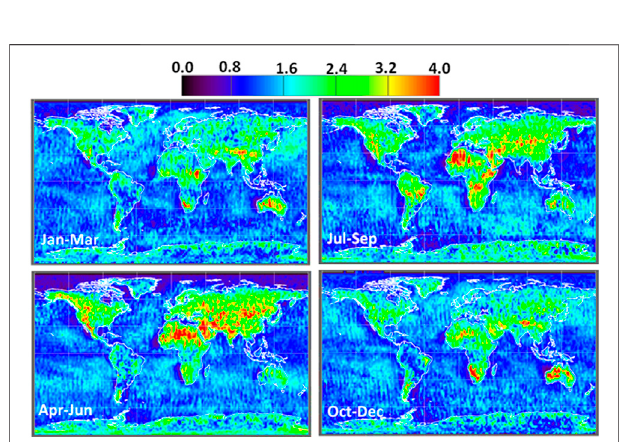
FIGURE 7 | MERRA-2 PBL height at 14:00 local time for each quarter of 2019.